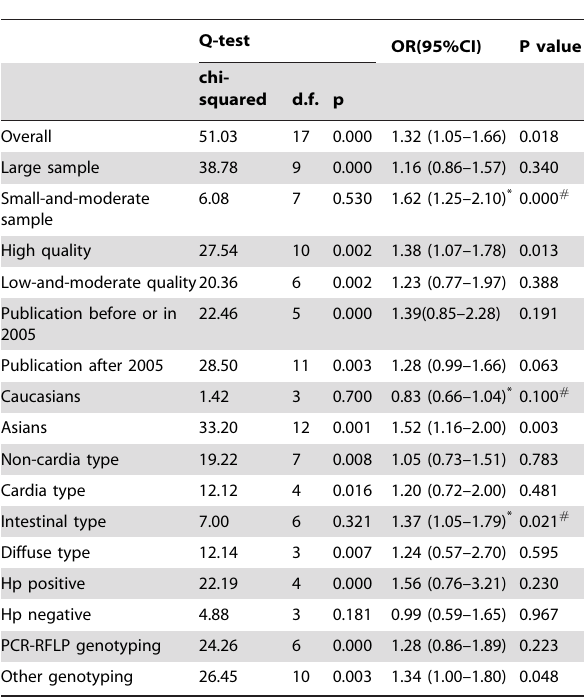
Table 2. Stratification for the test of heterogeneity on IL-8 - 251 AA vs TA based on a codominant model.